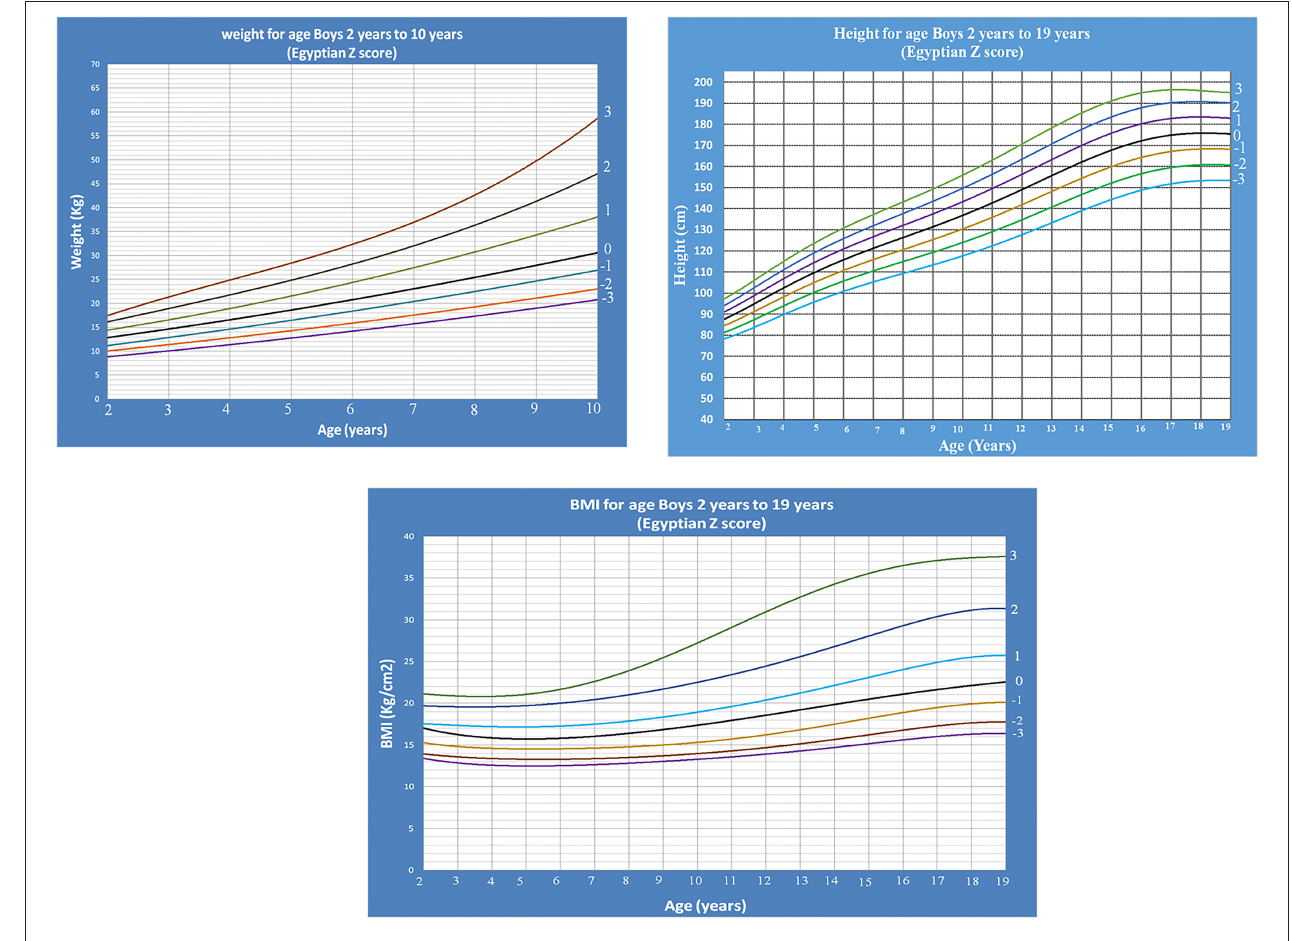
FIGURE 10 | Egyptian Z score weight-, height-, BMI- for age from 2 to 19 years for boys.